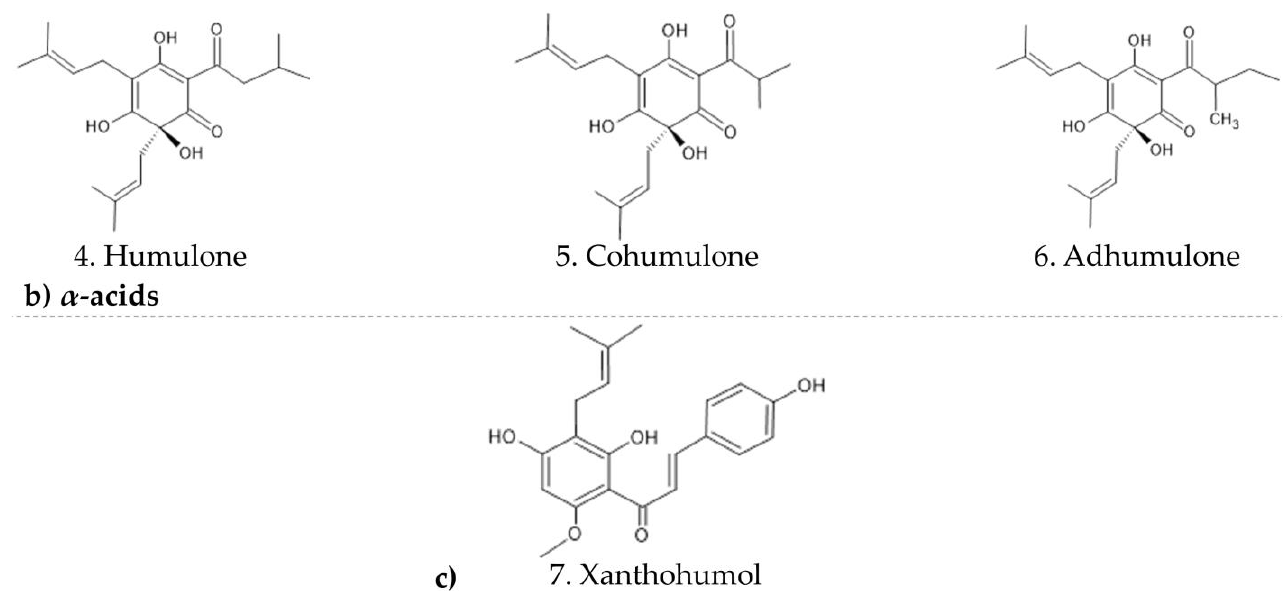
Figure 1. Chemical structures of tested compounds from hops on chikungunya virus strain: ( a ) β -acids, ( b ) α -acids and ( c ) xanthohumol.